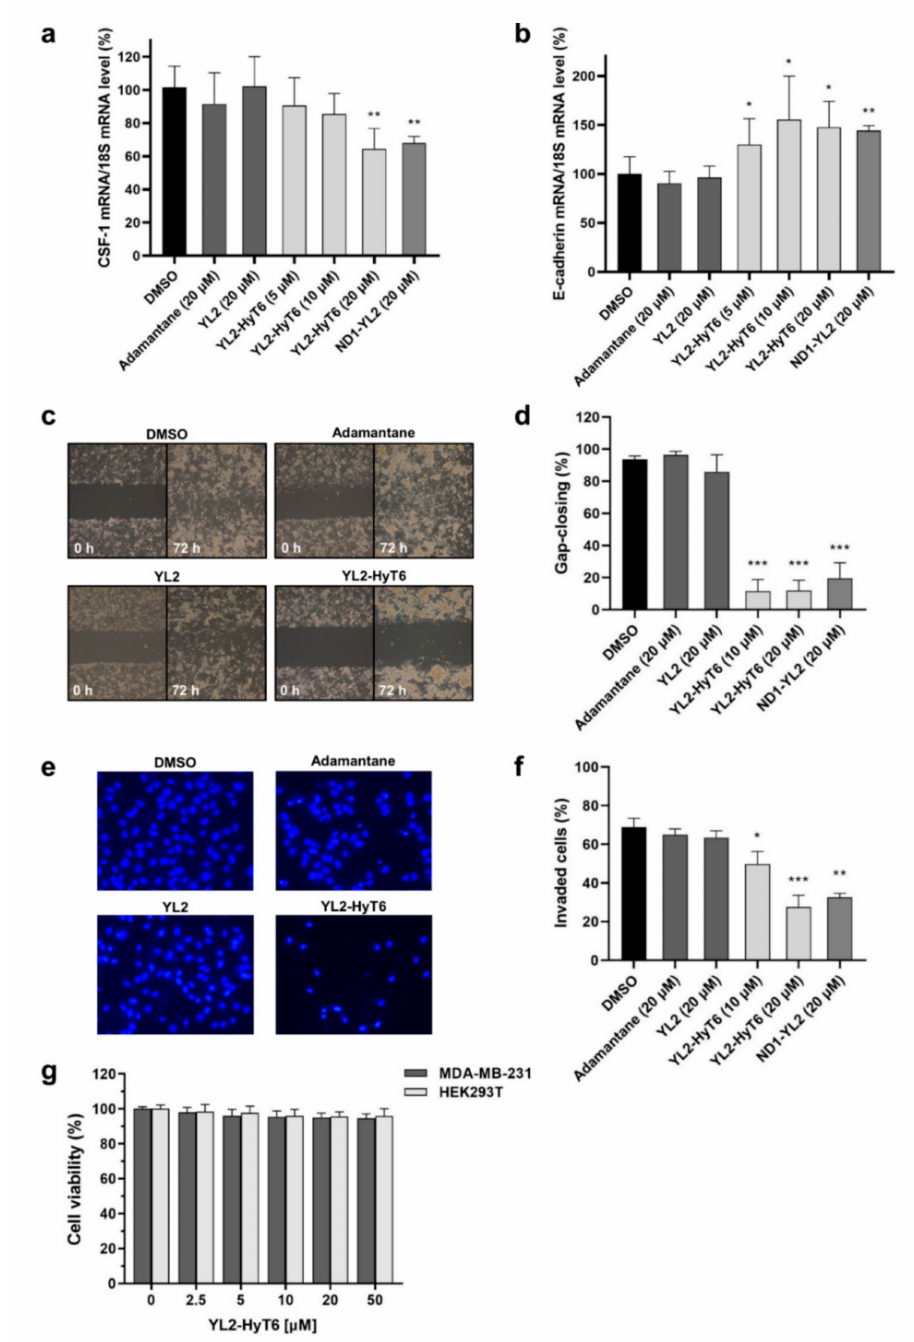
Figure 7. Cellular activities of YL2-HyT6. ( a ) CSF-1 and ( b ) E-cadherin mRNA expression levels in MDA-MB-231 cells after treatment with DMSO, hydrophobic tag, YL2, ND1-YL2, or YL2-HyT6 for 18 h were analyzed by RT-qPCR. Results are presented as levels of CSF-1 and E-cadherin genes in cells, which were normalized to the expression of the reference gene 18S . ( c ) Representative images from wound healing assay showing changes in MDA-MB-231 cell migration after treatment with DMSO, hydrophobic tag (20 µ M), YL2 (20 µ M), or YL2-HyT6 (20 µ M). Images of wound gap were taken at 0 and 72 h. ( d ) Quantitative analysis of wound gap closure in MDA-MB-231 cells. Results are presented as a percentage of gap-closed area. ( e ) Representative images of transwell invasion assay of MDA-MB-231 cells after treatment with DMSO, hydrophobic tag (20 µ M), YL2 (20 µ M), or YL2-HyT6 (20 µ M) for 24 h. ( f ) Quantitation of the invasion assay in MDA-MB-231 cells. Results are expressed as a percentage of invaded cells. ( g ) The effect of YL2-HyT6 on the survival of MDA-MB-231 and HEK293T cells after treatment for 48 h. Error bars in data represent standard deviation from three independent experiments. Statistical comparisons were performed using a two-tailed Student’s t -test. *, p < 0.05; **, p < 0.01; and ***, p < 0.001 vs. DMSO